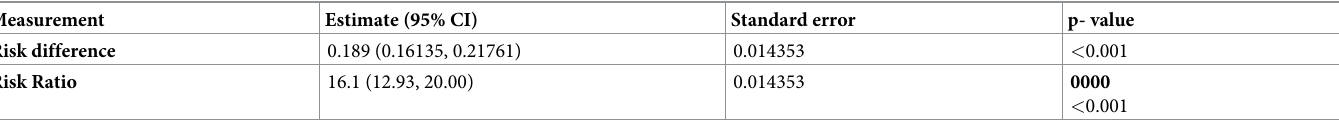
Table 2. Measurement of Targeted Maximum Likelihood Estimation